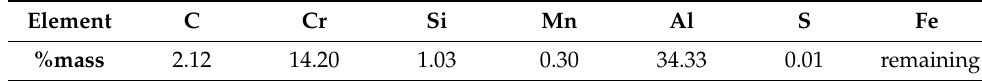
Table 2. Chemical composition of high-aluminum cast iron.